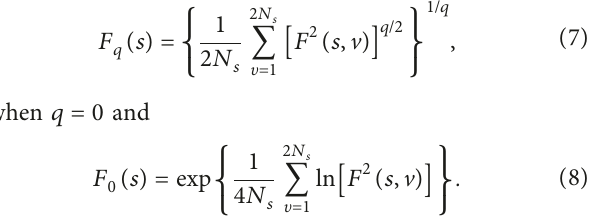
Figure 2: Evolution pattern of US economic policy uncertainty index